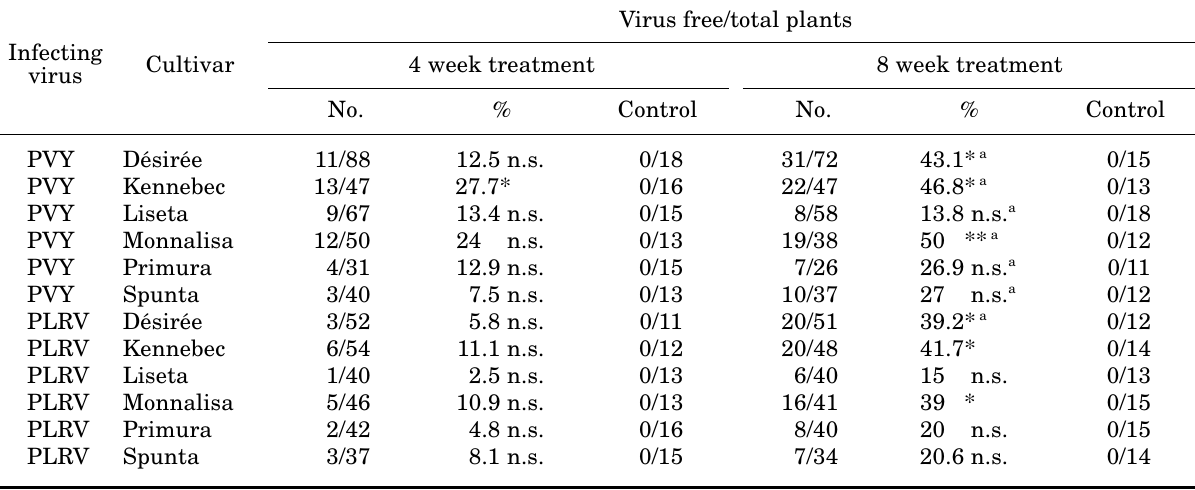
Table 1. Eradication of potato virus Y (PVY) and potato leafroll virus (PLRV) from potato stem cuttings (0.15 (cid:1) 0.5 cm) of various cultivars by chemoterapy in vitro with ribavirin (50 mg l -1 ) and DHT (100 mg l -1